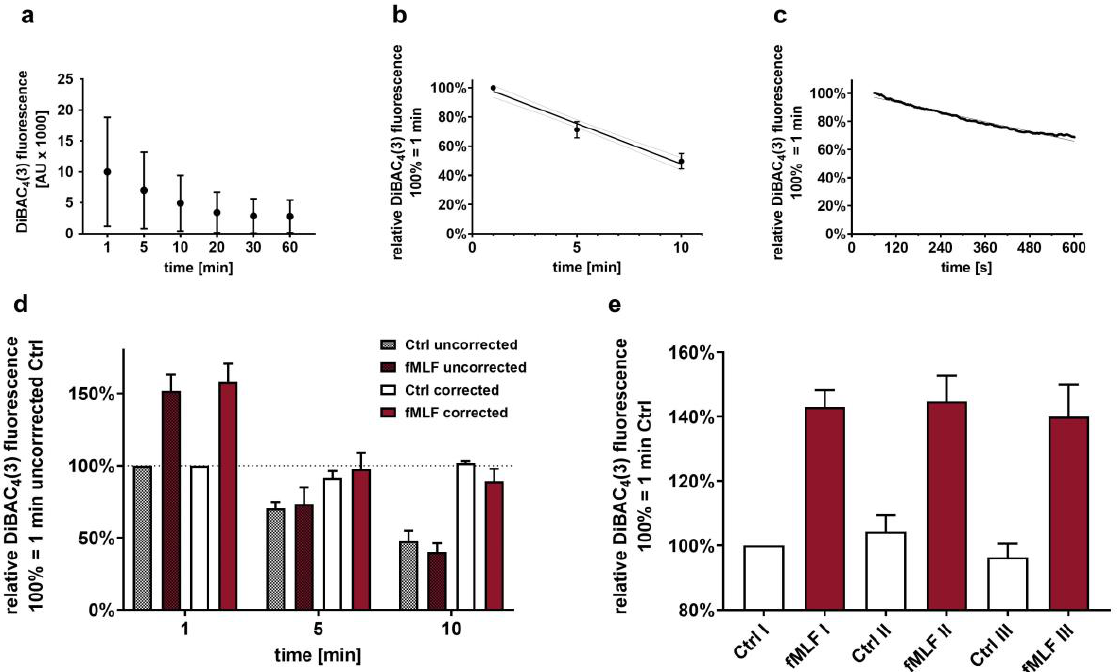
Figure 1. Characterization of the DiBAC 4 (3) fluorescence over time. ( a ) Demonstration of the loss of DiBAC 4 (3) fluorescence in unstimulated neutrophils after a 10 min resting period ( n = 6). The loss of fluorescence is nearly linear within the first 10 min as evaluated by conventional measurement ( n = 6) at time points of 1, 5, and 10 min ( b ) as well as by near realtime measurement (representative measurement) ( c ) after a 10 min resting period without further stimulation. ( d ) Illustrates the impact of the correction regarding the loss of DiBAC 4 (3) fluorescence ( n = 15). ( e ) The measurement of the MP assay has a small coefficient of variation when measuring six tubes consecutively (alternating sequence of independent control and fMLF-stimulated tubes as illustrated) from the same donor normalized to the first tube ( n =